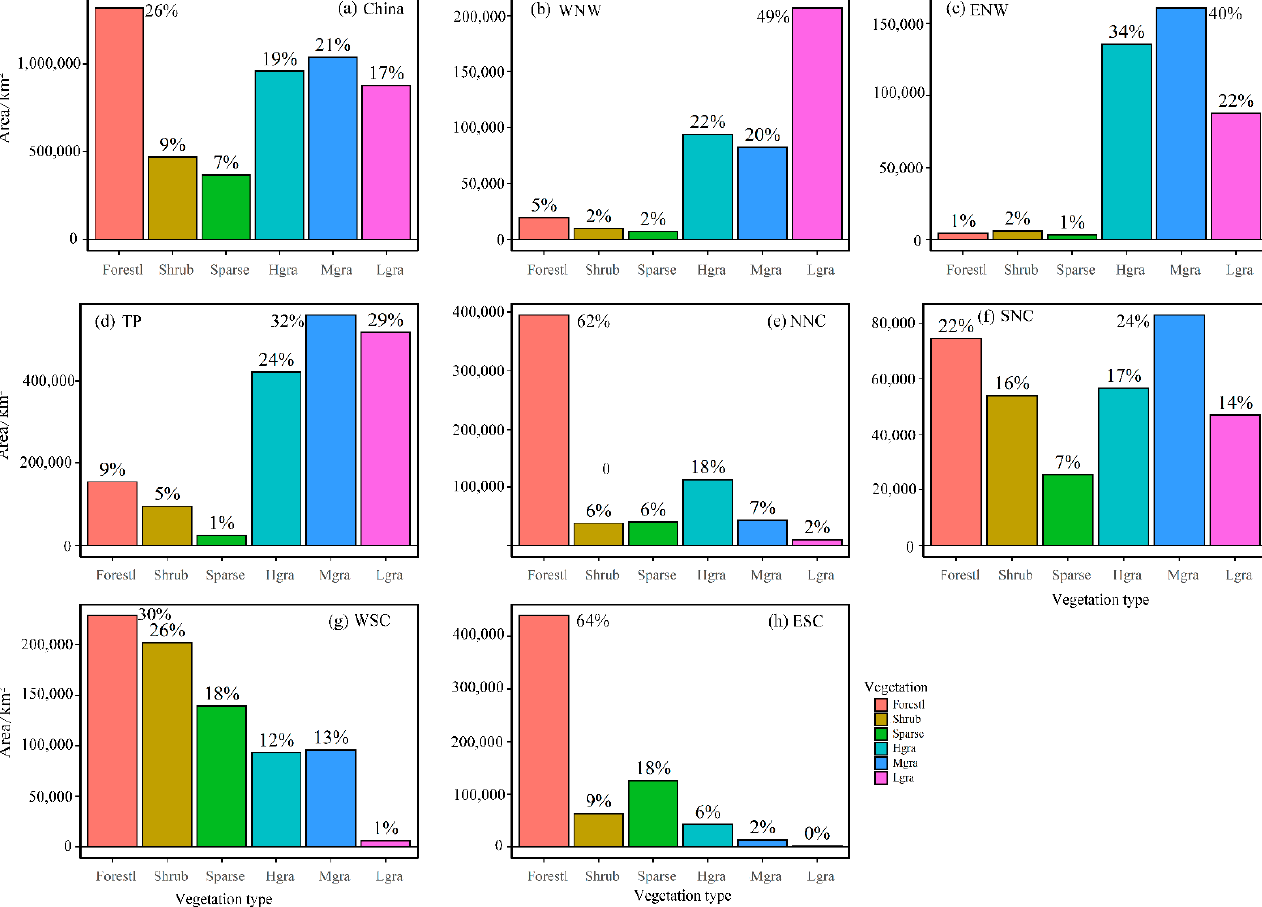
Figure 3. Areas and proportions of different types of natural forest and grassland in China from 1980 to 2015. ( a ) China; ( b ) WNW—Western arid and semi-arid region; ( c ) ENW—Eastern arid and semi-arid region: ( d ) TP—Qinghai-Tibet alpine region; ( e ) NNC—Northern North China; ( f ) SNC—Southern North China; ( g ) WSC—Western South China; ( h ) ESC—Eastern South China.